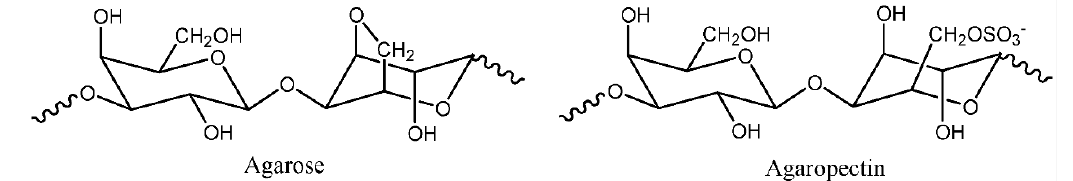
Figure 7. Representative structure of agarose and agaropectin.